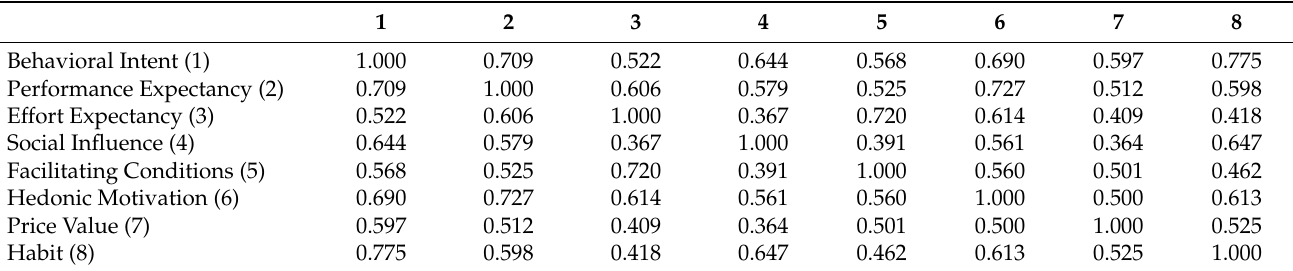
Table 8. Correlations among research variables.